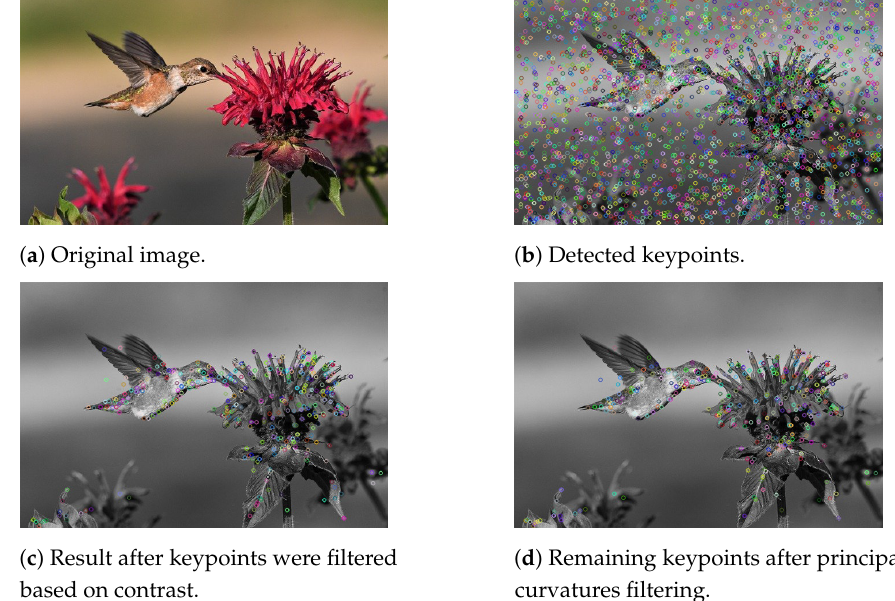
Figure 7. Detection of keypoints and further selection of invariant features: ( a ) illustrates the original image; ( b ) illustrates with circles the keypoints identified by the Difference-of-Gaussian function. These keypoints are then filtered based on their contrast. The remaining keypoints are depicted in ( c ); ( d ) represents the prevailing keypoints after further exclusion due to principal curvatures ratio threshold. Adapted from